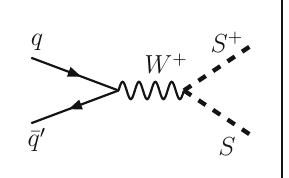
Fig. 28 Feynman diagram for associated dark S + S production at the